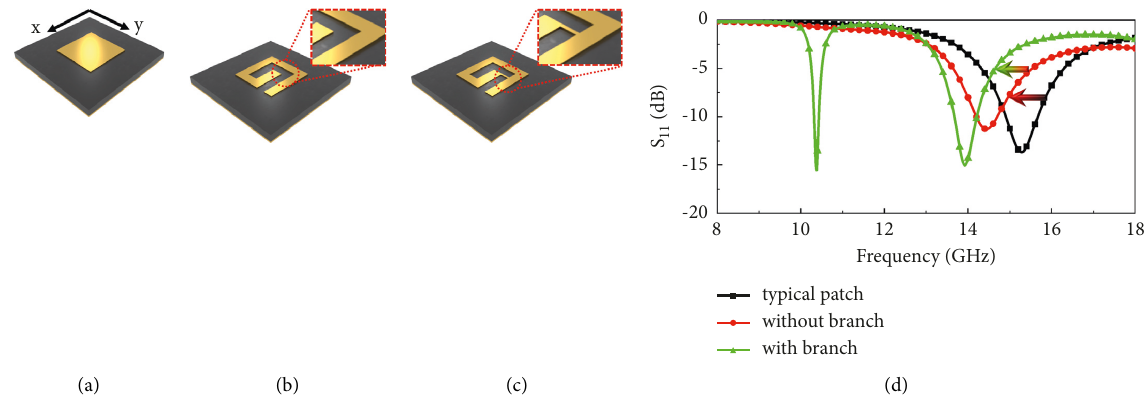
Figure 2: (a) A typical rectangular patch antenna. (b) Patch with slot cut. (c) Patch with the short branch loaded. (d) Simulated of different